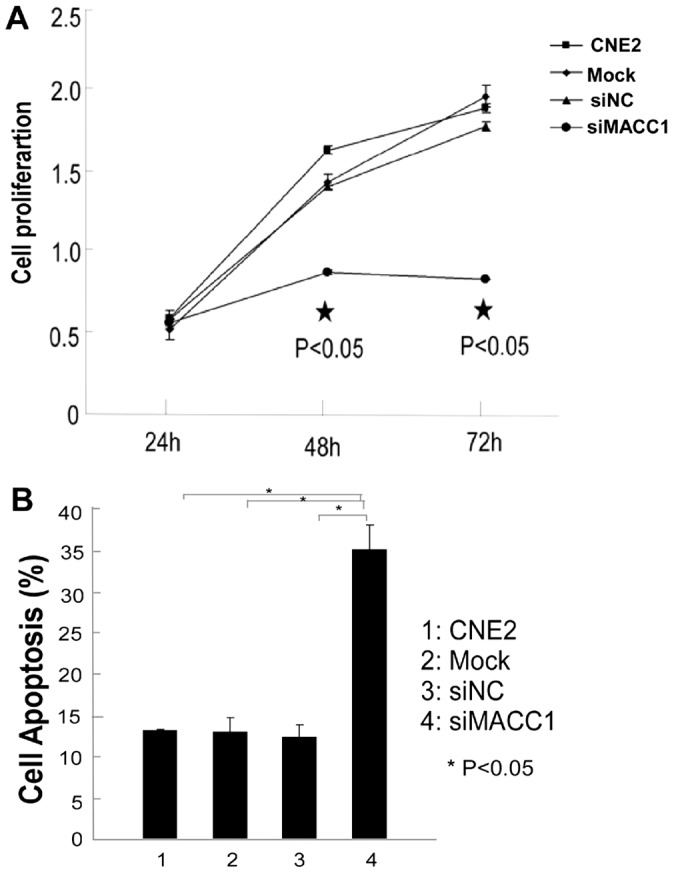
MACC1 knockdown (siMACC1) dramatically suppressed cell proliferation of CNE2 at 48 hours and 72 hours compared with the scramble siRNA(siNC), mock, and untreated CNE2 group by MTT analysis, respectively.*p<0.05 (A), but induced apoptosis of CNE2 transfected with MACC1 siRNA at 48 hours compared with the control group by flow cytometry analysis. *p<0.05(B).